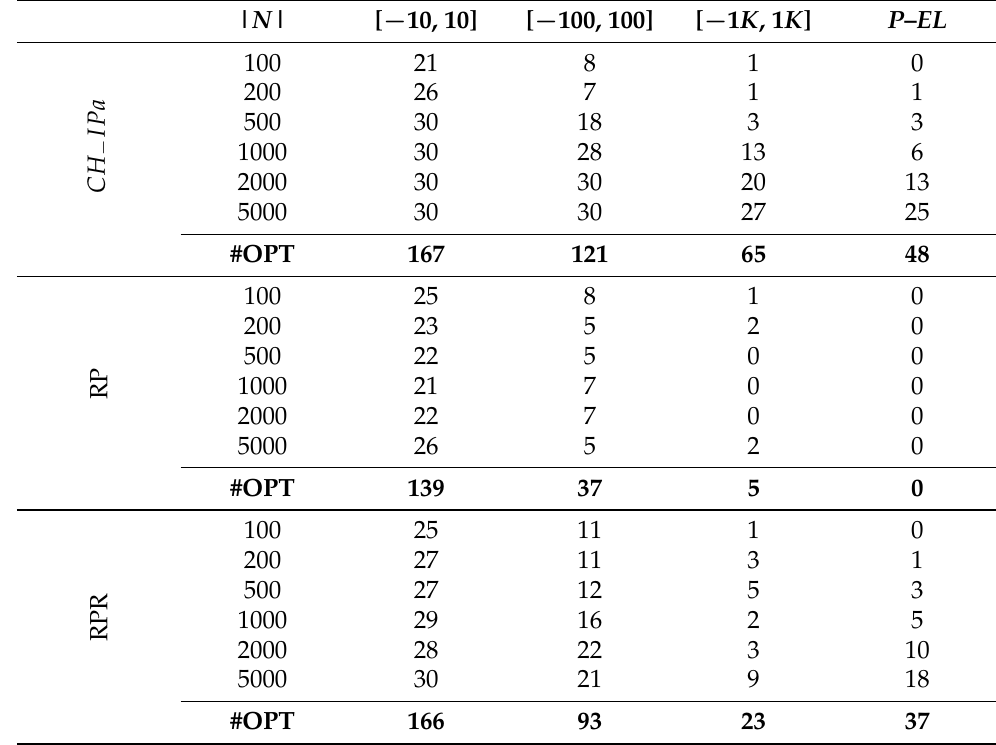
Table 7. Comparison of the number of optimal solutions